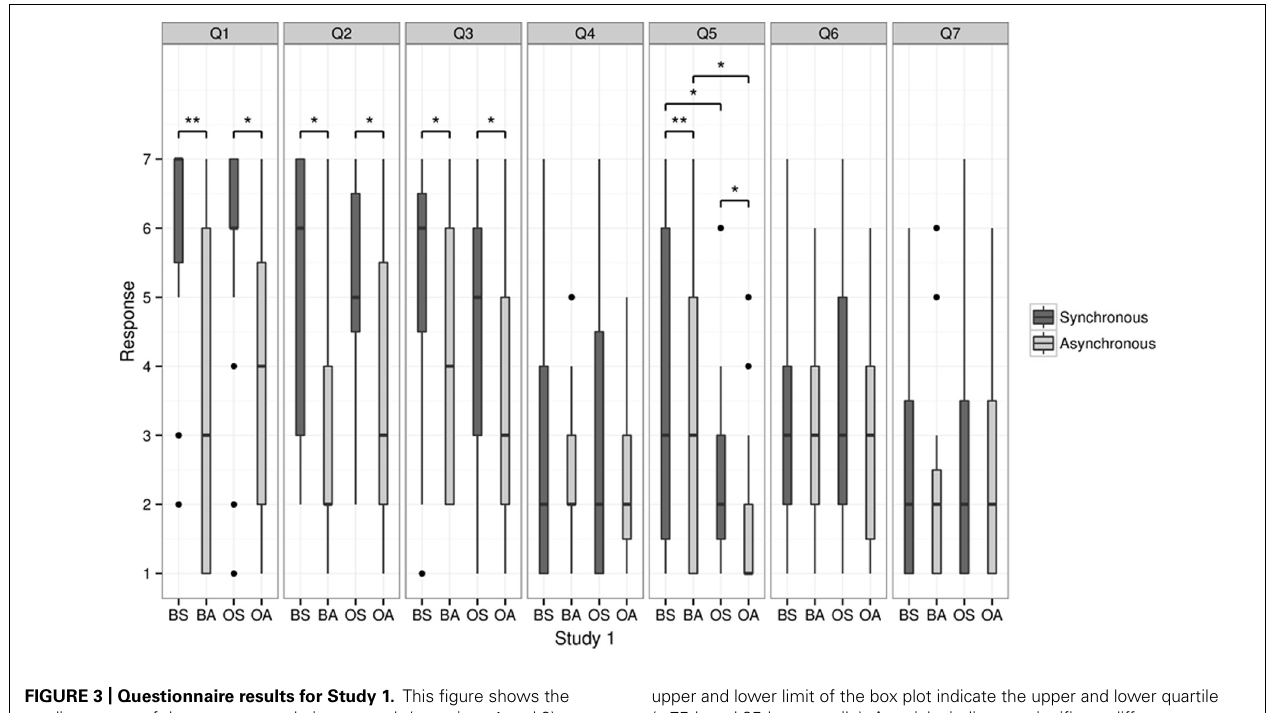
FIGURE 3 | Questionnaire results for Study 1. This figure shows the median scores of the responses relating to touch (questions 1 and 2), self-identification (question 3), the sensation of having more than one body (question 5), as well as question 4, 6, and 7. Bold line indicates the median,